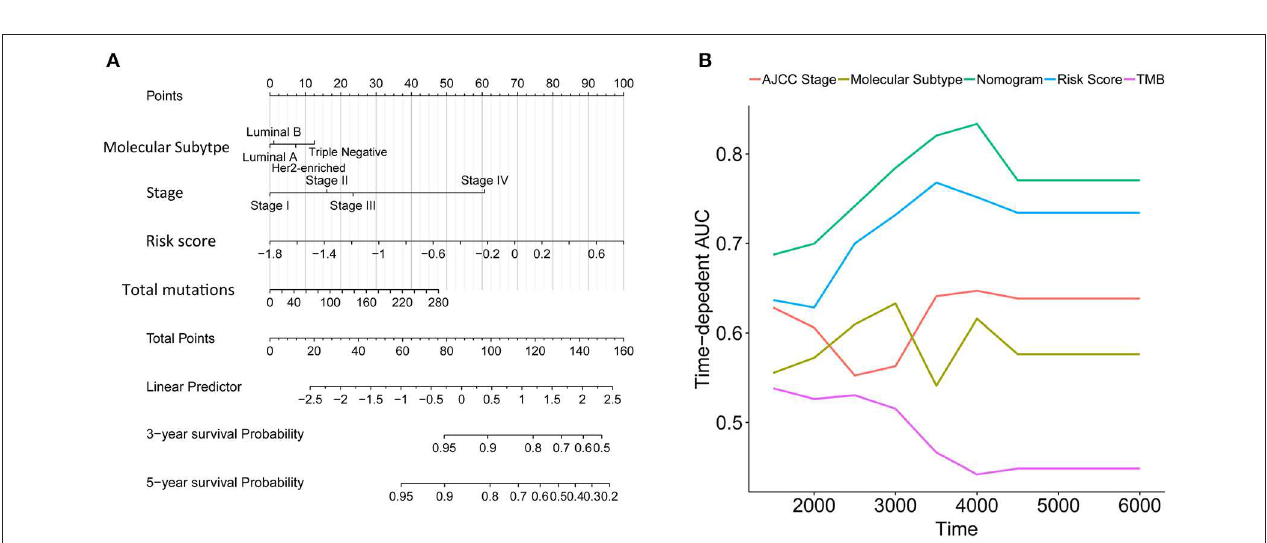
FIGURE 7 | Construction of a nomogram for survival prediction. (A) Nomogram combining the immune signature with clinicopathological features. (B) The AUC(t) of the multivariable models indicated that the nomogram had the highest predictive power for overall